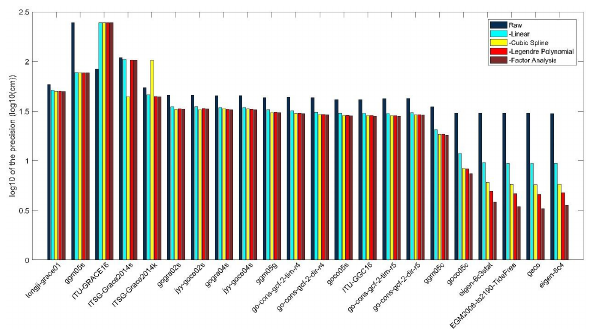
Figure 10: The logarithm plot of the precision of various ICGEM mod- els at the NAVD 88 benchmarks and all the counterparts after re- moving the systematic errors modeled by a linear model, a B-Spline model, a Legendre-polynomial model, and FA